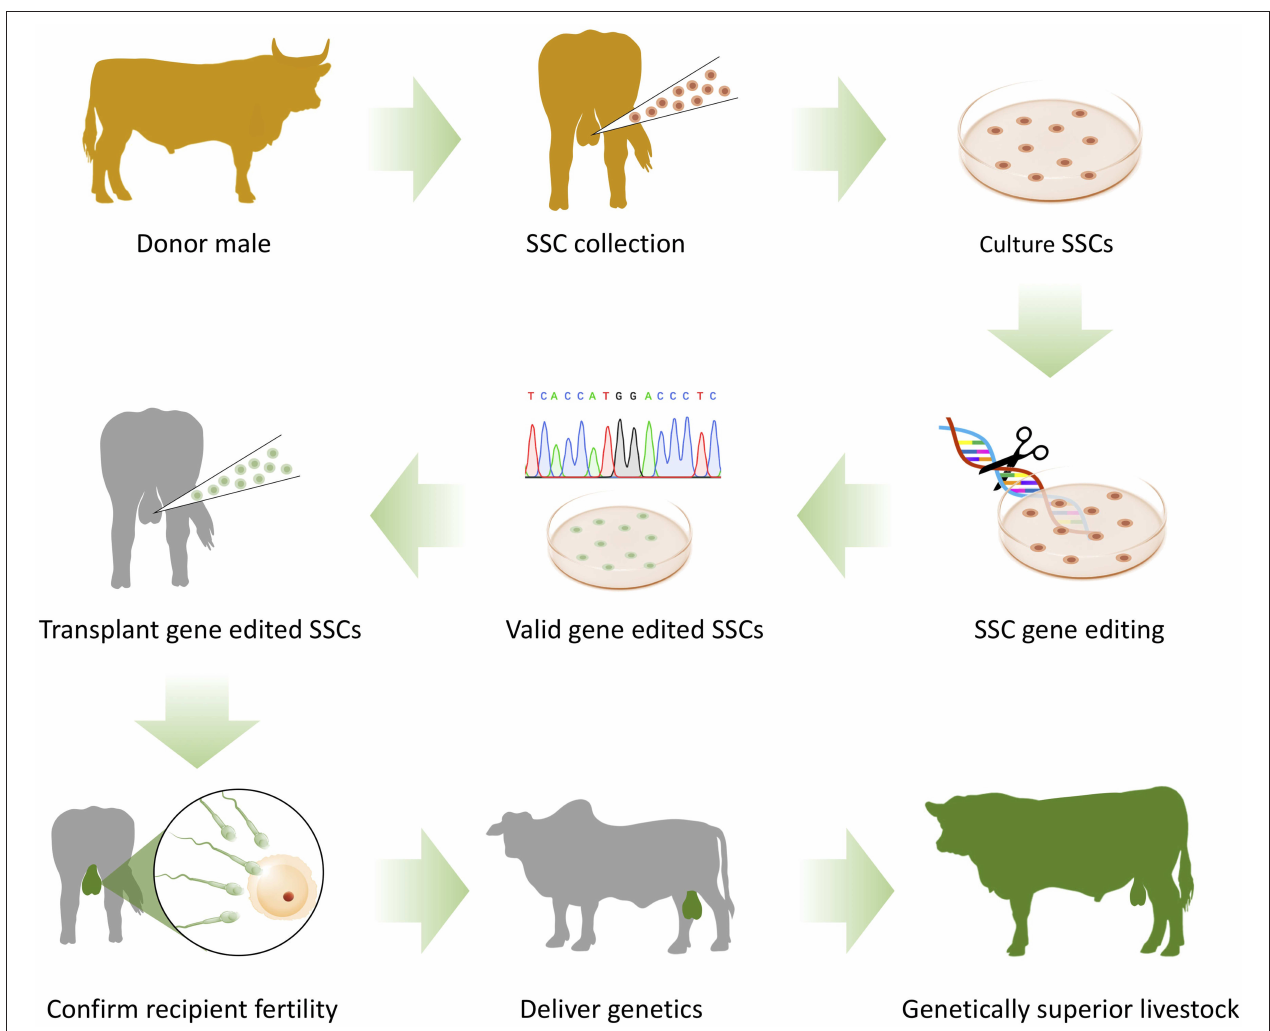
FIGURE 2 | Genome editing with surrogate sire technology (SST). A spermatogonial stem cell (SSC) sample is collected on-farm by needle testicular biopsy from a donor male with suitable genetic merit. SSC sample is shipped to a laboratory that cultures and expands the cells in vitro . Genome editing tools are added into SSCs in culture to introduce trait/s of interest. Gene edited SSCs are validated and transplanted into the testis of germline ablated recipient male. SSC colonization of the testis and fertility of recipient male is confirmed before delivering surrogate sires to the farmer. Surrogate sires are then introduced into the breeding program to disseminate the superior germline